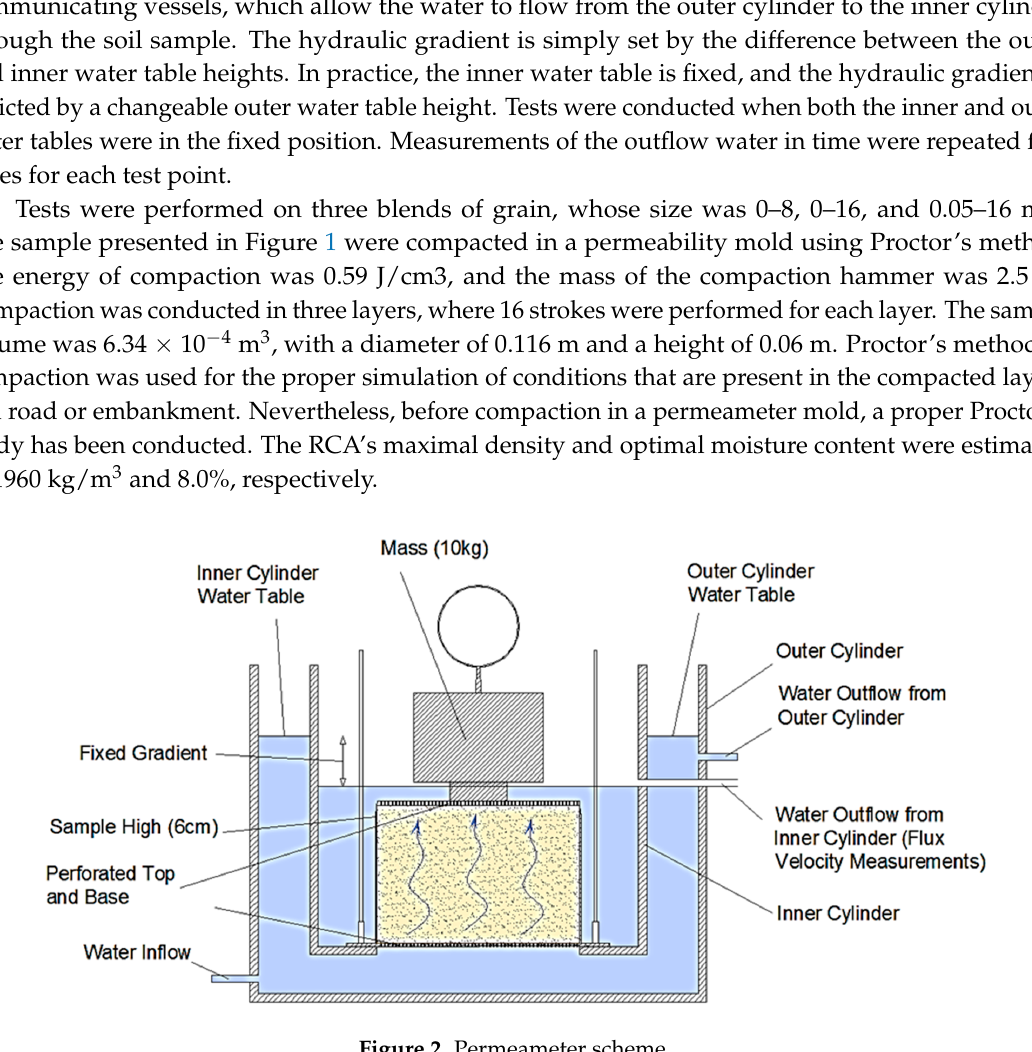
Figure 2. Permeameter scheme.